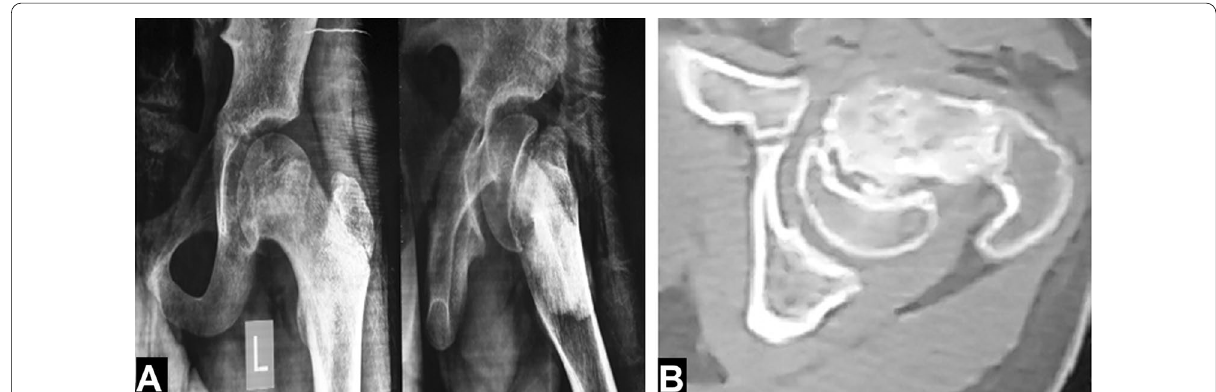
Fig. 1 Preoperative images of a 13‑year‑old male patient with left chronic SCFE. A Plain X‑rays (AP and lateral views). B CT axial cut